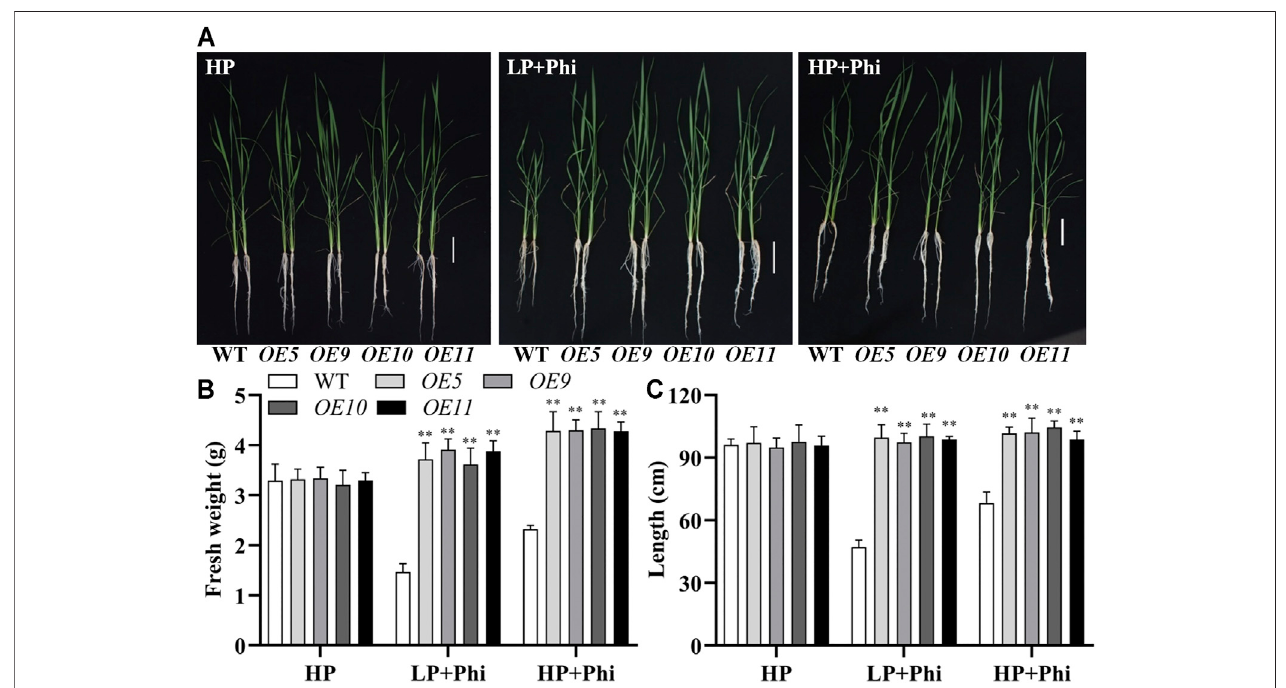
FIGURE 5 | Effect of phosphite on the growth of WT and ptxD Q transgenic rice under low and high phosphate conditions. Growth performance (A) , fresh weight (B) ,andplantheight (C) ofWT( ZH11 )and PtxD Q overexpression( OE5 , OE9 , OE10 ,and OE11 )ricegrownunderdifferentphosphorusnutrientconditions.Fourteen-day- old seedlings were transferred to nutrientsolutions containing 300 μ M phosphate (HP), 10 μ M phosphate plus 300 μ M phosphite (LP + Phi), or 300 mM phosphite plus 300 μ M phosphite (HP + Phi). Scale bar (cid:2) 5 cm. The data are shown as means ± SD for fi ve replicates. Asterisks indicate signi fi cant differences as compared with WT plants (Turkey ’ s test, ** p ≤